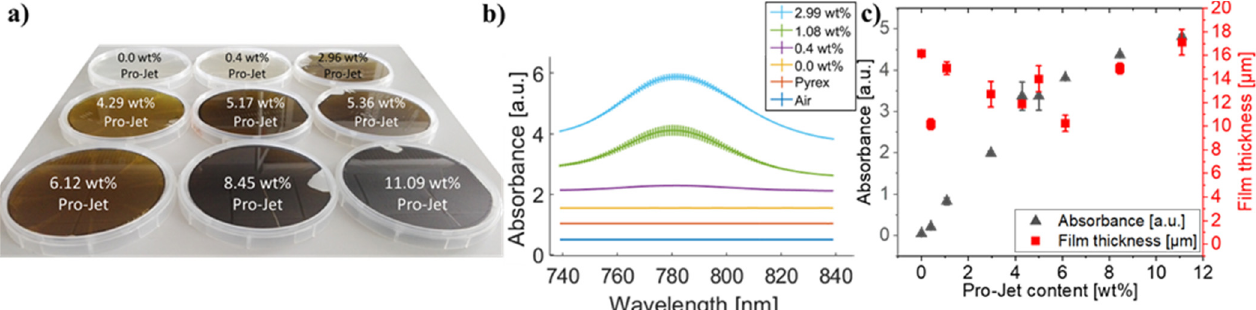
Figure 2. ( a ) Images of boron glass wafers coated with SU-8 containing different concentrations of Pro-Jet 800NP. ( b )